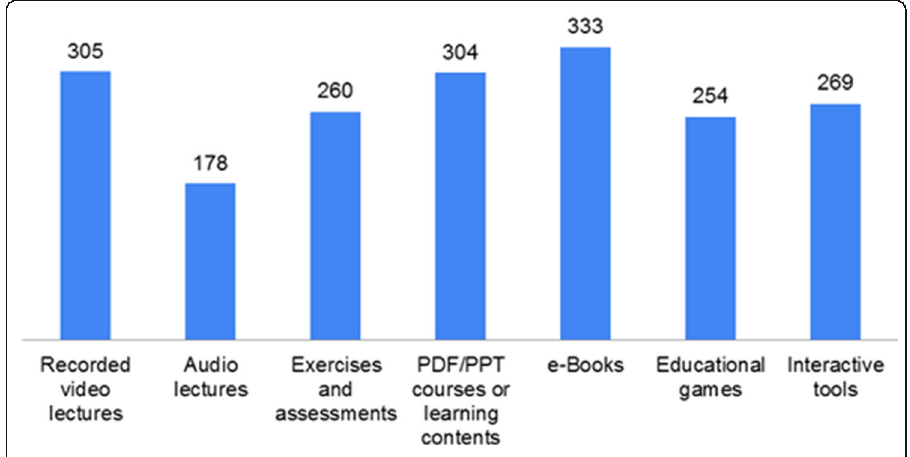
Fig. 6 Preferred OER types in the Arab